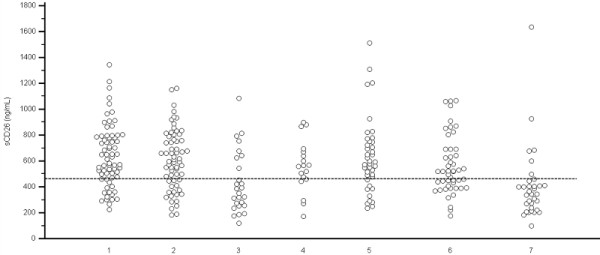
Dot plot representing the sCD26 concentration according to the colonoscopic diagnosis. Horizontal line: 460 ng/mL cut-off. 1: No colorectal findings (n = 68); 2: non-IBD (n = 64); 3: IBD (n = 26); 4: hyperplastic polyps (n = 18); 5: non-advanced adenomas (n = 40); 6: advanced adenomas (n = 48); 7: CRC (n = 33).